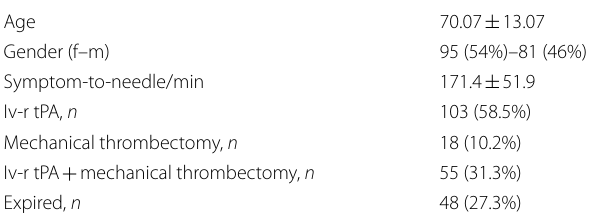
Fig. 1 Effect of glucose levels in the first 4 days on clinical severity and mortality. *baseline NIHSS **24th hour